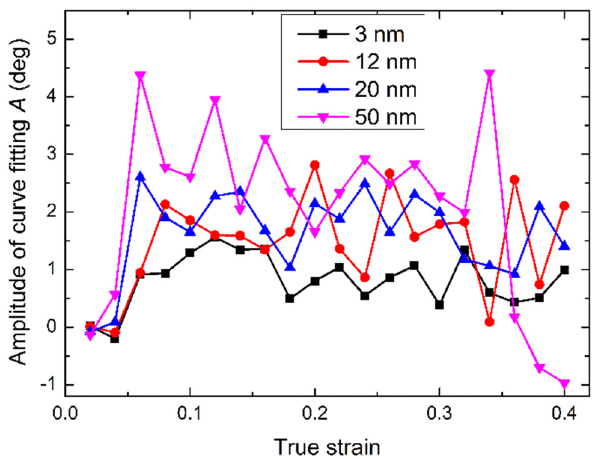
Figure 9: Variation of the amplitude of grain rotation increment with the strain.